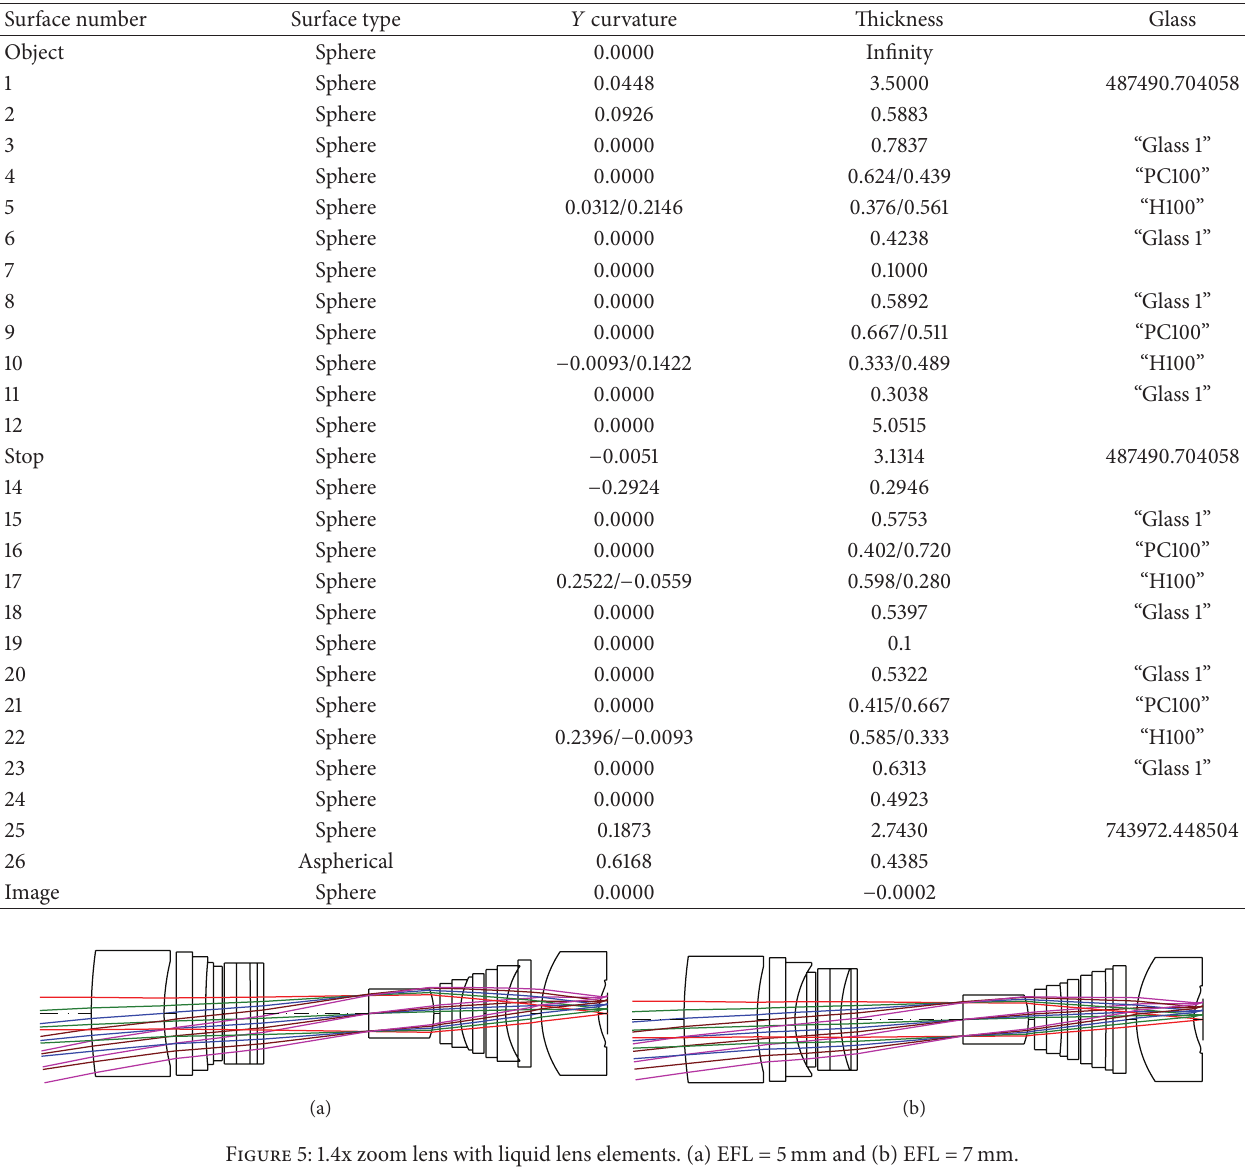
Table 4: The factors after the GA optimization.